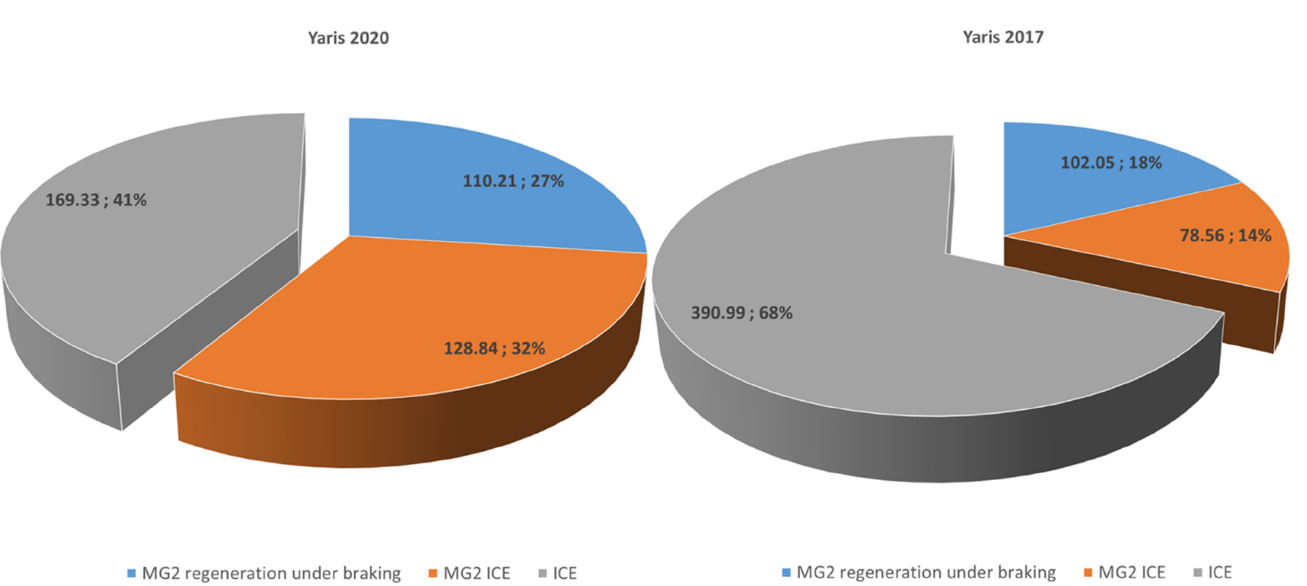
Figure 16. Distribution of energy flows to transmission.